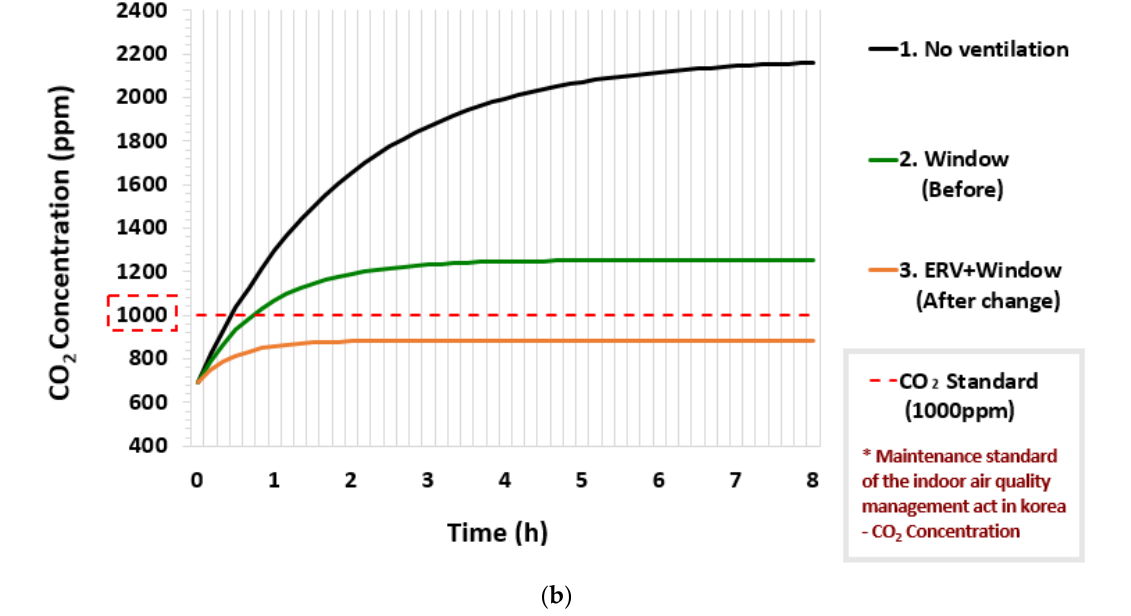
Figure 11. Variation in CO 2 concentration: ( a ) input conditions and ( b ) prediction graph; * CO 2